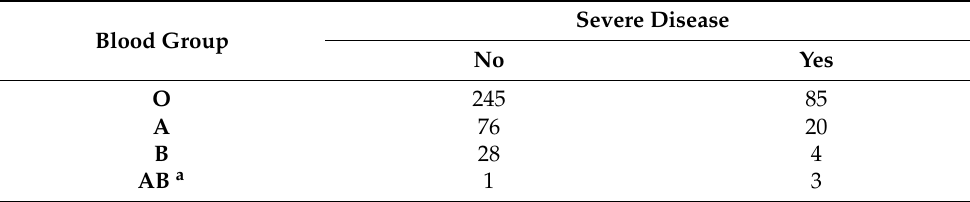
Table 3. Presence of severe symptoms among mothers by blood group. Blood